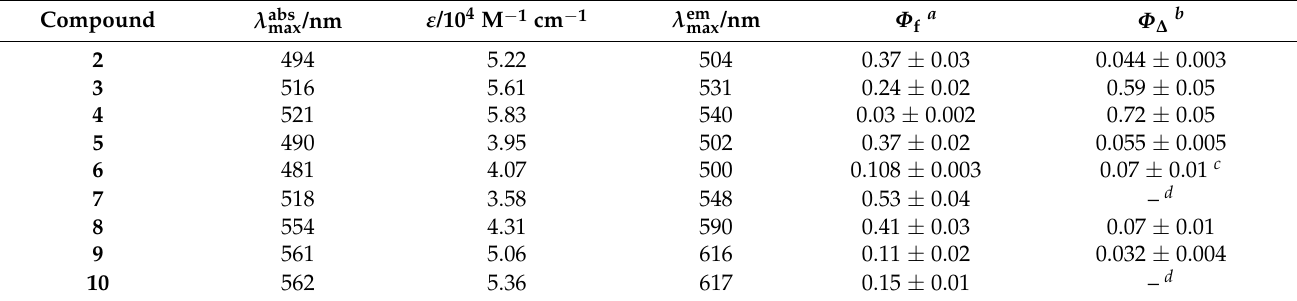
Table 1. Photophysical properties of meso -Carboxy BODIPY derivatives in methanol.